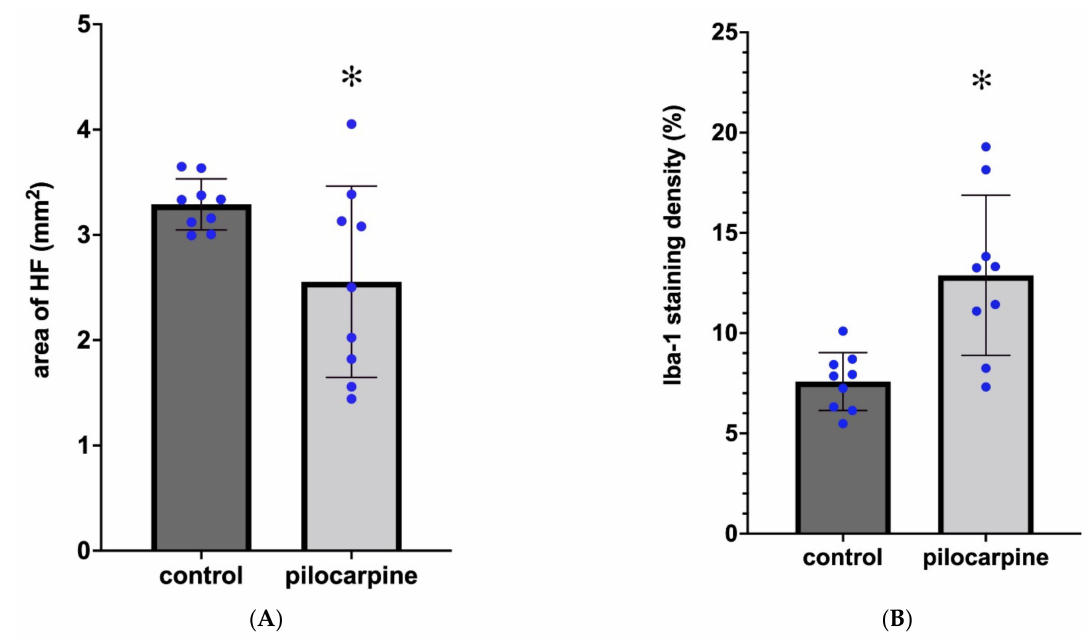
Figure 3. ( A ) Decrease in the cross-sectional area of the HF in PT animals compared with controls, as measured on coronal sections (n = 9; Wilcoxon signed rank test, * p = 0.0039). ( B ) Increase in the Iba1 staining density in the HF in PT animals compared with controls (n = 9; paired t -test, * p =